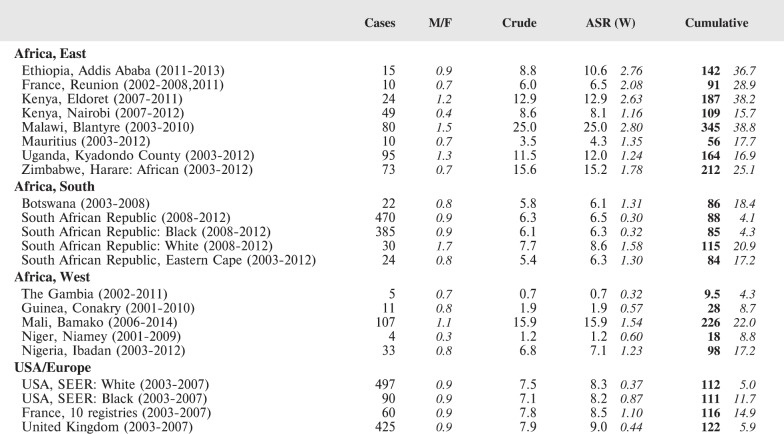
Crude, age-standardised (world) and cumulative (0–14) incidence rates (per million) and standard errors—nephroblastoma.